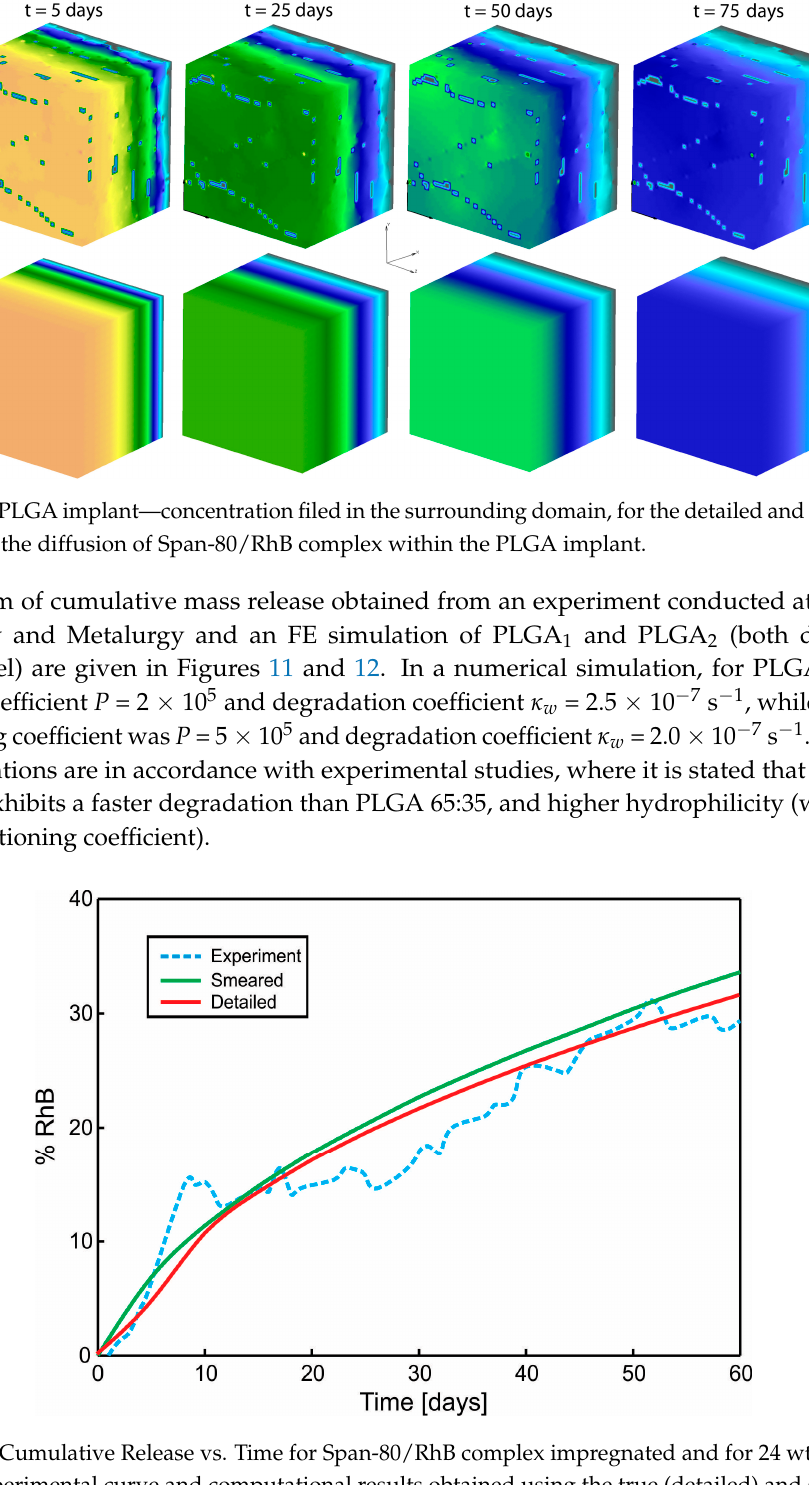
Figure 9. PLGA implant—concentration field for the detailed and smeared model, for the diffusion of Span-80/RhB complex within the PLGA implant.